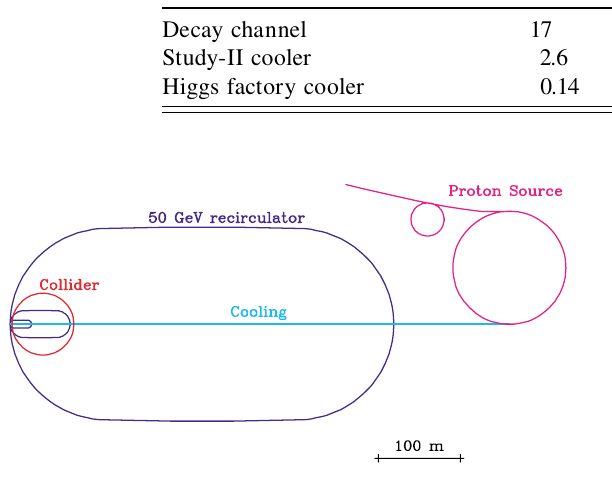
FIG. 33. (Color) Plan of a 0.1-TeV-CoM muon collider, also known as a Higgs factory.